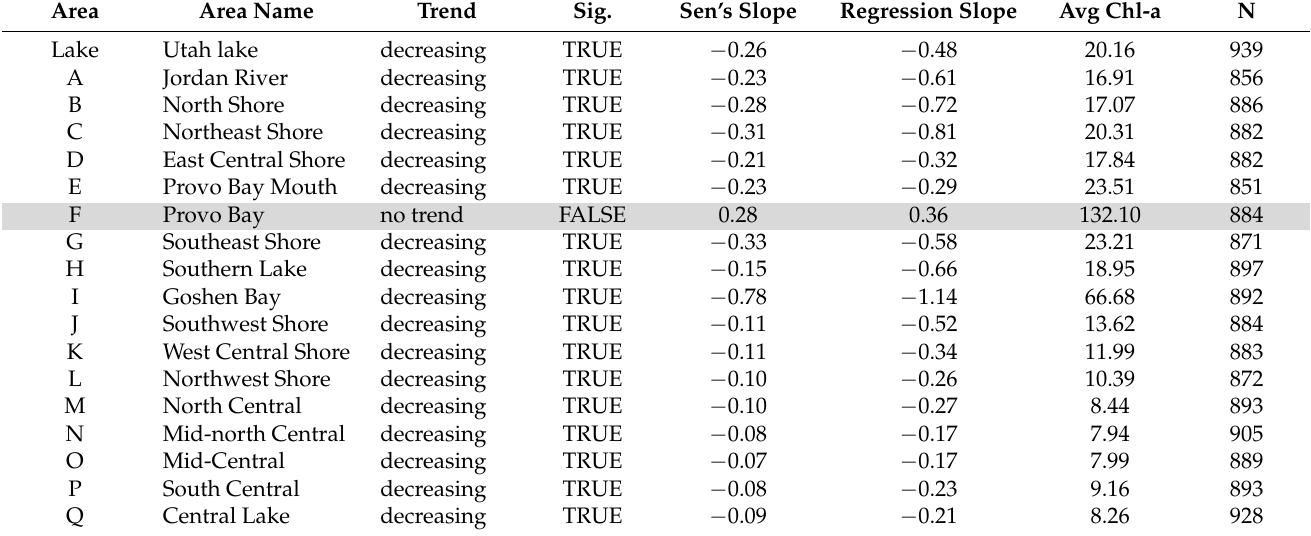
Table 3. Trend analysis results for data from the entire study period including winter